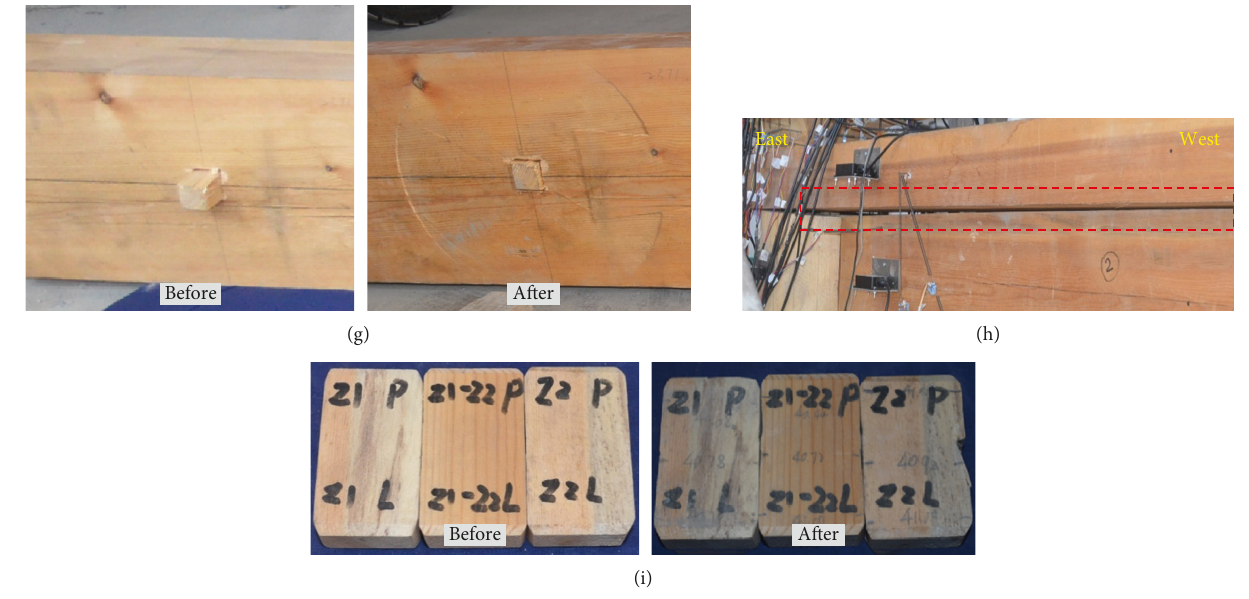
Figure 6: Deformation of the test